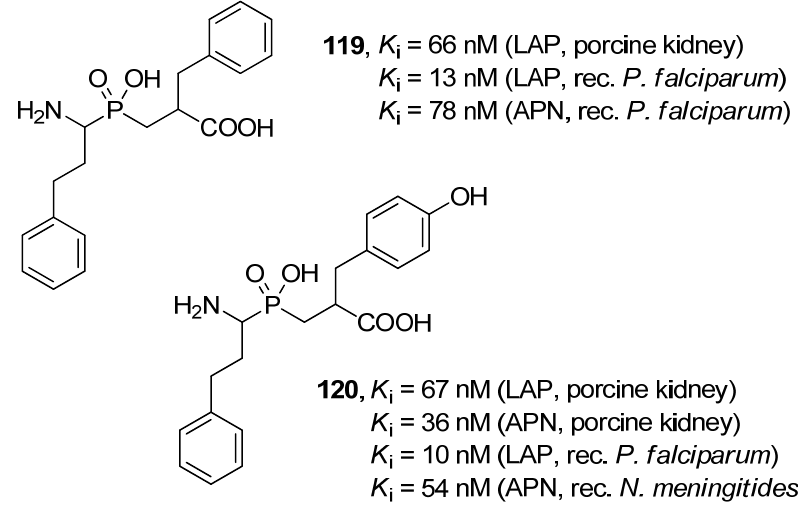
]-Phe and hPhe  [P(O)(OH)CH 2